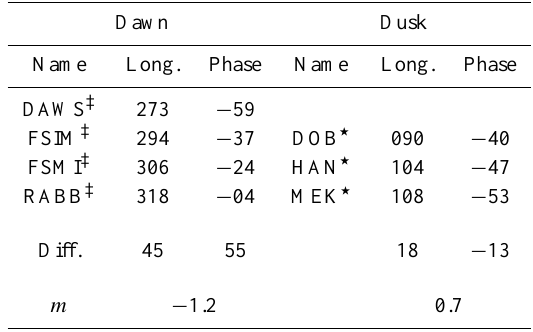
Table 1. Phase in degree at 17.2mHz for different stations along longitudinal profiles determined by Fourier analysis.